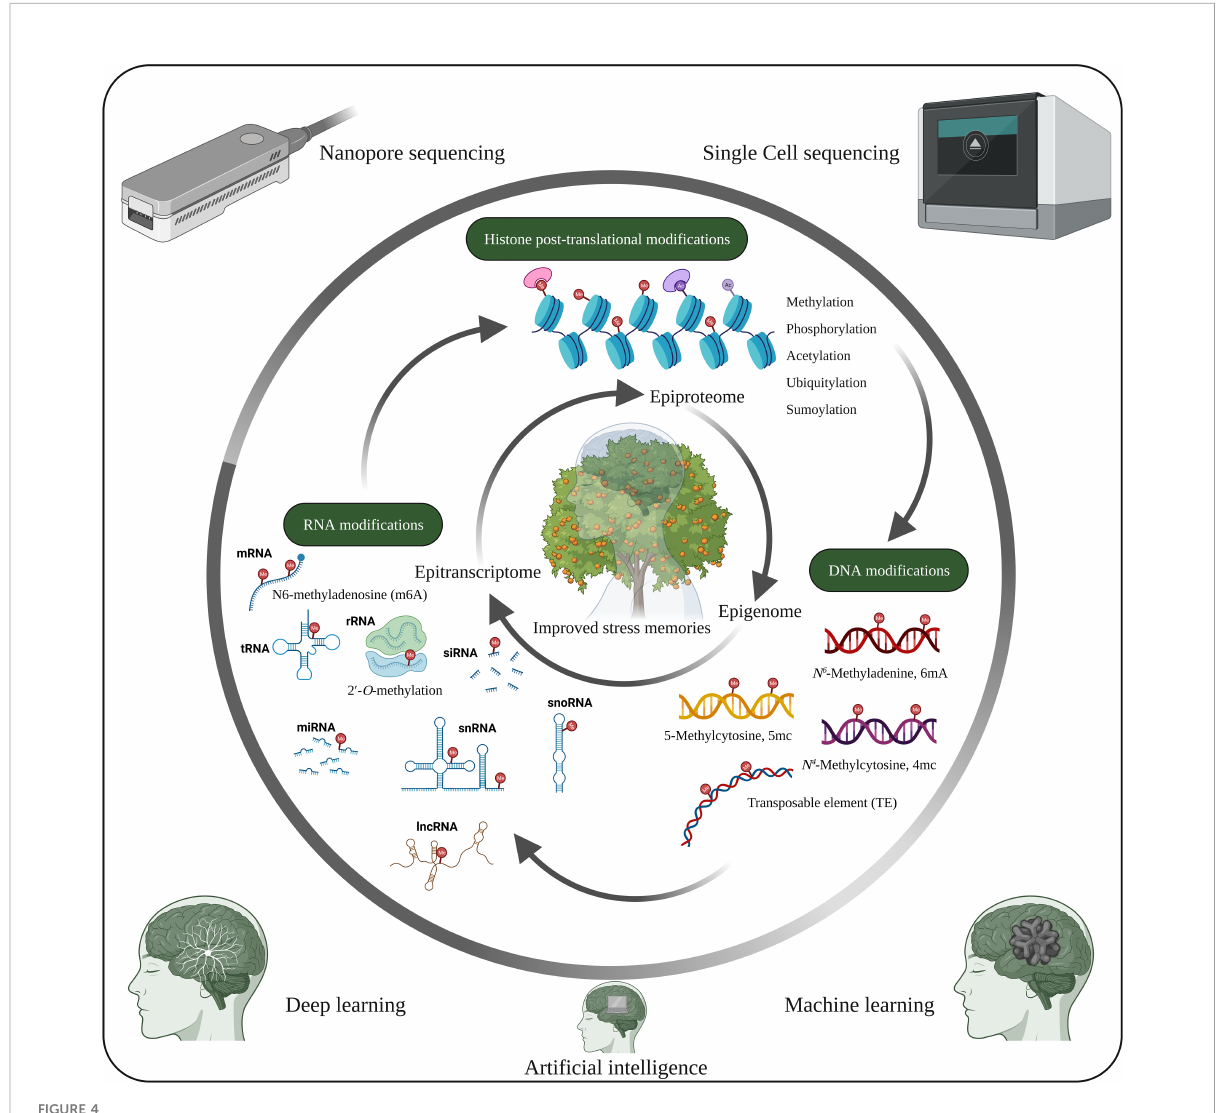
FIGURE 4 Future opportunities in plant stress memory. Cellular functions and stress tolerance depend on DNA, RNA and histone modi fi cations, which are closely interconnected and lead to different phenotypic traits. However, the functions of the tissue-speci fi c epigenome, epitranscriptome and epiproteome with respect to stress memory have not yet been extensively studied. Therefore, studies on the tissue-speci fi c epigenome, epitranscriptome and epiproteome, along with recent developments such as arti fi cial intelligence, machine learning, deep learning,